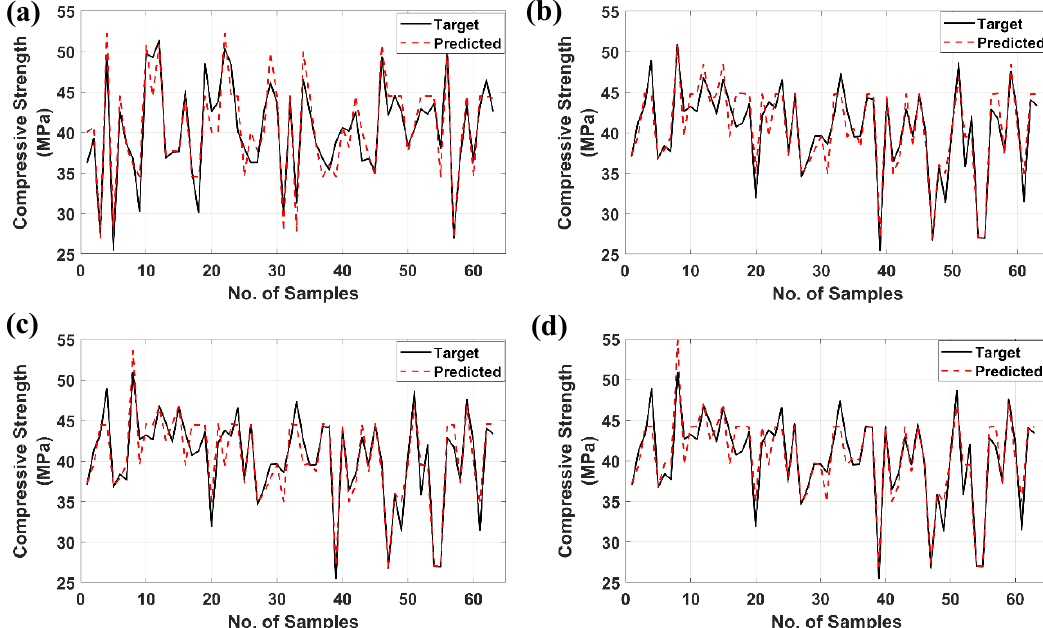
Figure 9. Target and ANFIS-predicted values of compressive strength using three input parameters: ( a ) Testing Fly Ash + Na 2 SiO 3 + NaOH, ( b ) testing Fly Ash + Na 2 SiO 3 + H 2 O, ( c ) testing Fly Ash + NaOH + H 2 O, and ( d ) testing Na 2 SiO 3 + NaOH + H 2 O.